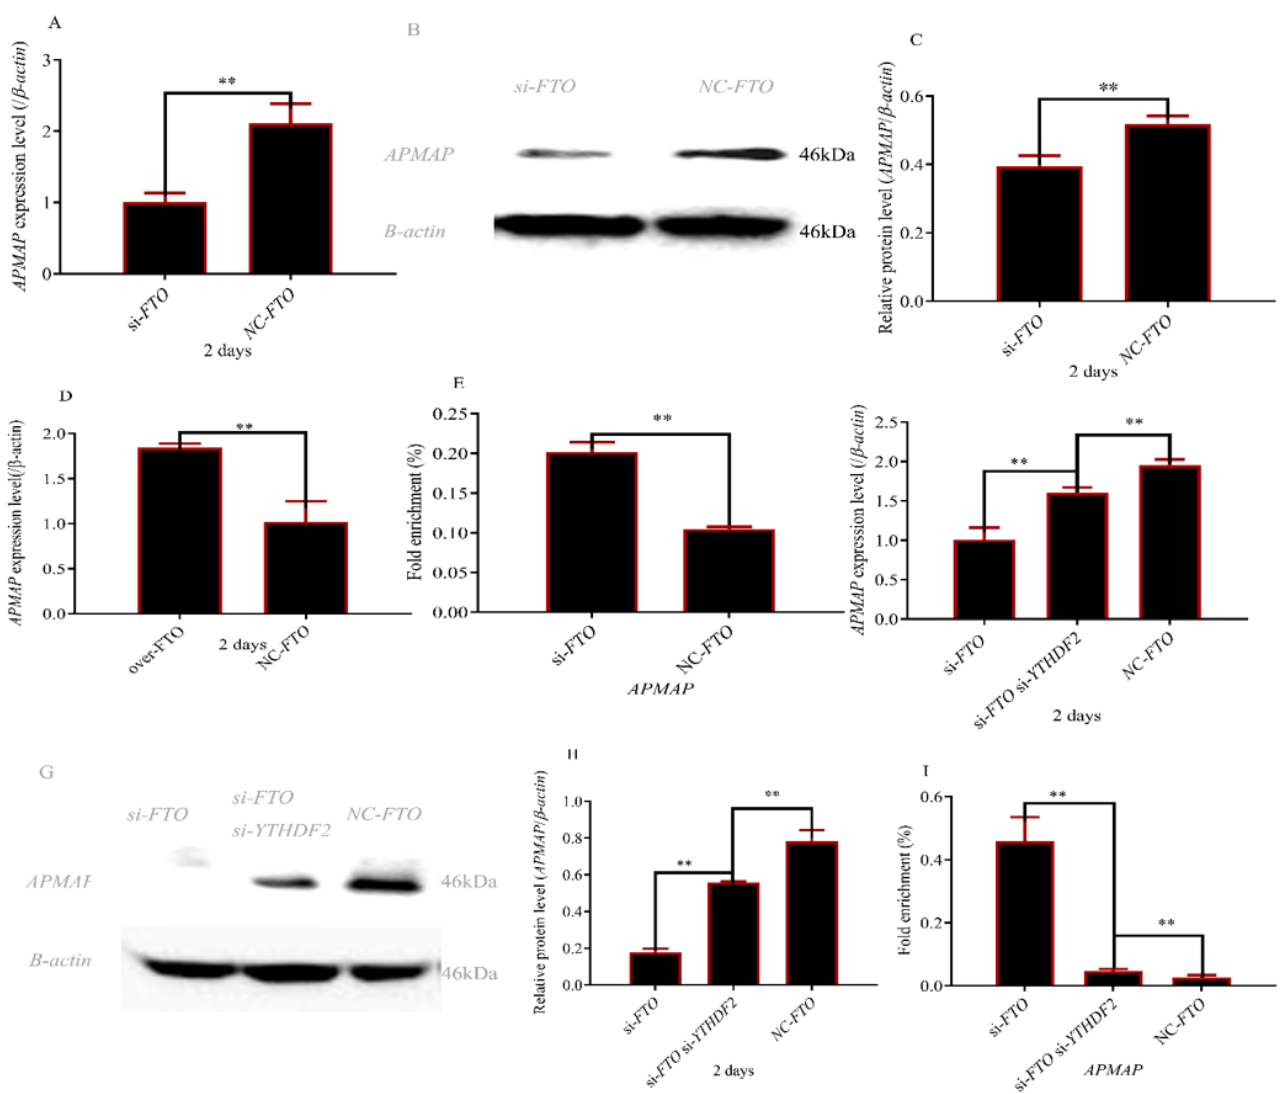
Figure 5. FTO upregulated APMAP expression level in an m6A-YTHDF2 manner. ( A ) APMAP expression level after interfering with FTO gene; ( B,C ) APMAP protein level after interfering with FTO gene; ( D ) APMAP expression level after overexpression of FTO ; ( E ) fold enrichment of APMAP gene after interfering with FTO gene; ( F ) APMAP expression level after interfering with FTO and YTHDF2 genes; ( G,H ) APMAP protein levels after interfering with FTO and YTHDF2 genes; ( I ) fold enrichment of APMAP gene after interfer- ing with FTO and YTHDF2 genes; ( ** p ≤ 0.01